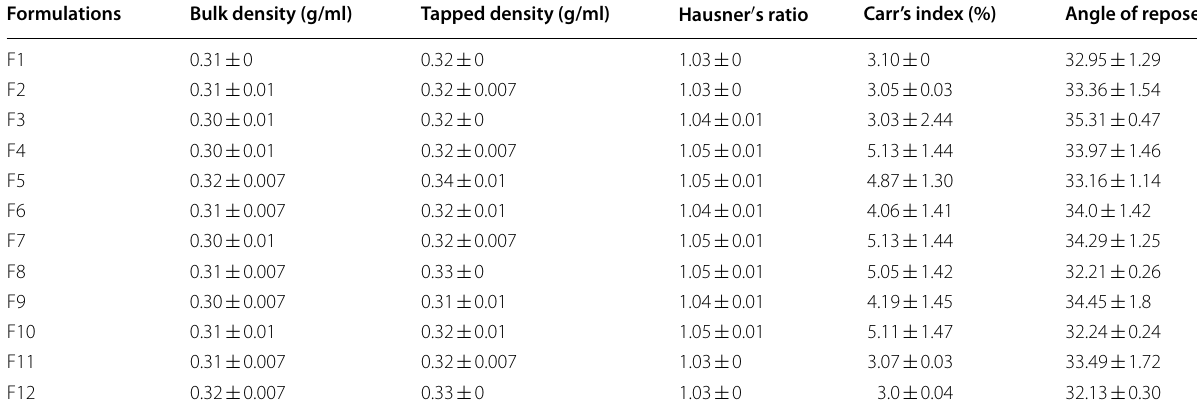
Table 10 Post-compression parameters Formulations